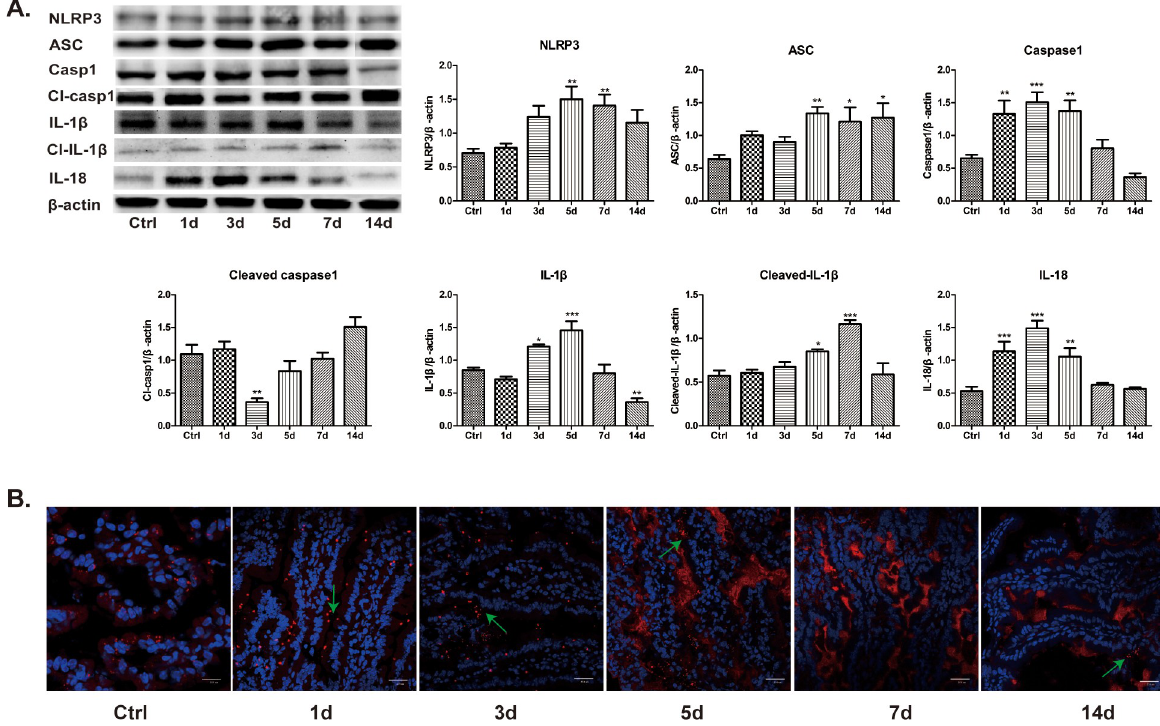
Fig 6. Antibiotics activates NLRP3 inflammasome. A. After antibiotics treatment, protein expressions of NLRP3, ASC, cleaved caspase-1, cleaved IL-1 β and IL-18 increased significantly. But expressions of caspase-1 and IL-1 β decreased gradually. Data represent the mean ± SEM (n = 6). � p < 0.05, �� p < 0.01, ��� p < 0.001 compared with control. B. Antibiotics remarkably augmented the amount of ASC protein (red punctate). Scale bar = 25.0 μ m.